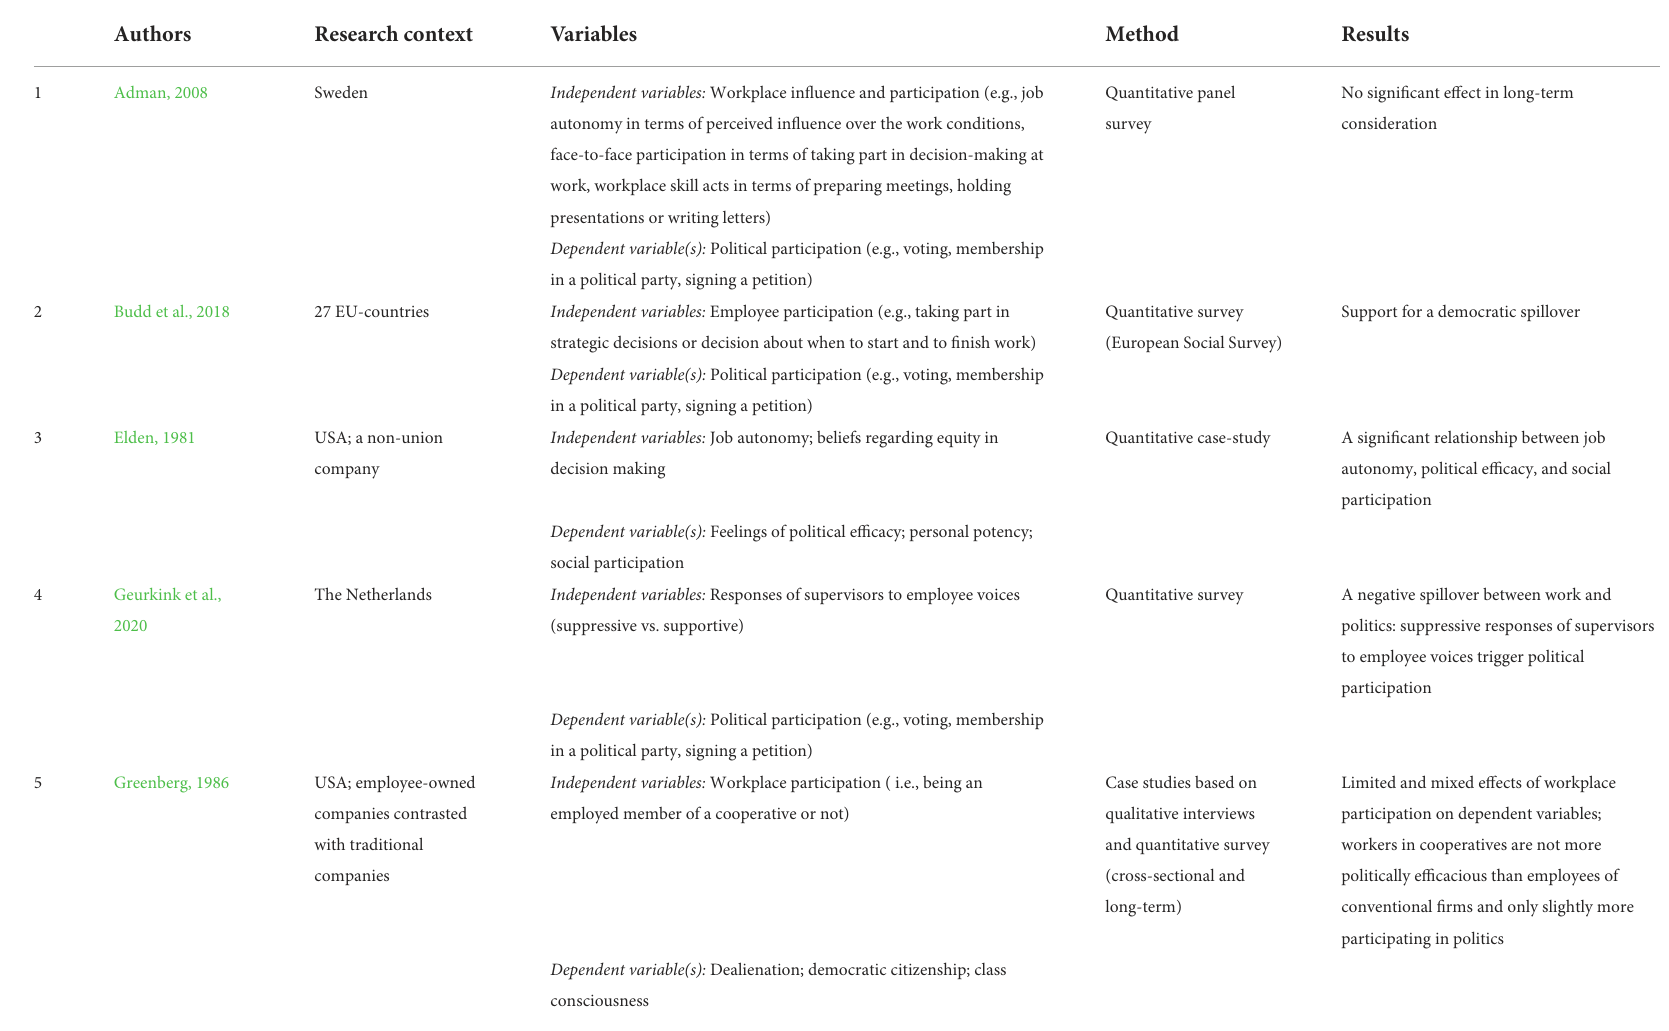
TABLE 1 Overview of empirical studies addressing democratic